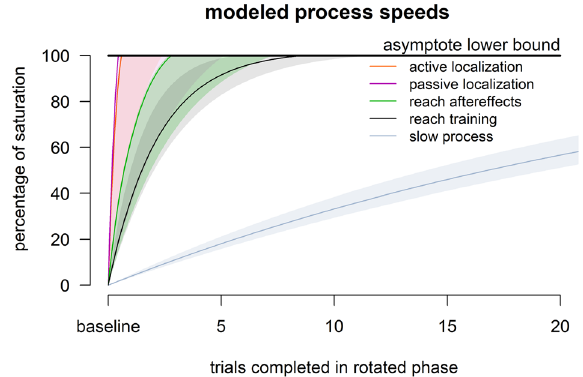
Figure 4. Overview of Results. For each of the five processes considered in the paper, the plot shows the change from baseline (0%) to the lower limit of the 95% confidence interval of the asymptote (100%). For the reach adaptation and the two-rate model’s slow process, the highest rate of change is used. As is clear, the measures of implicit adaptation (reach aftereffects and hand localization shifts) are faster than adaptation and much faster than the model’s slow